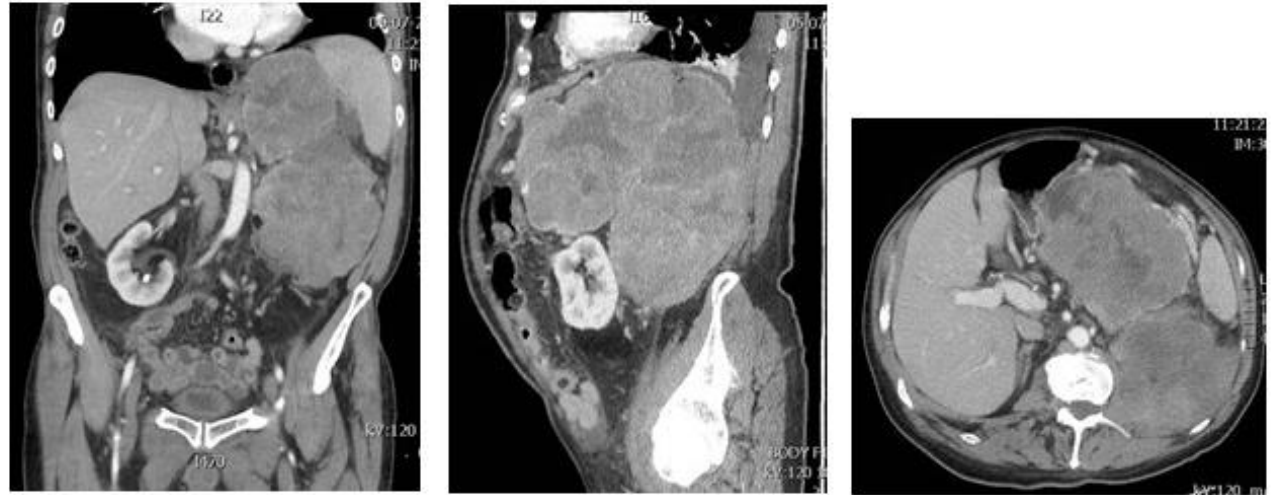
Figure 6. MRI pictures of a big retroperitoneal tumor in an 82-years-old male patient.